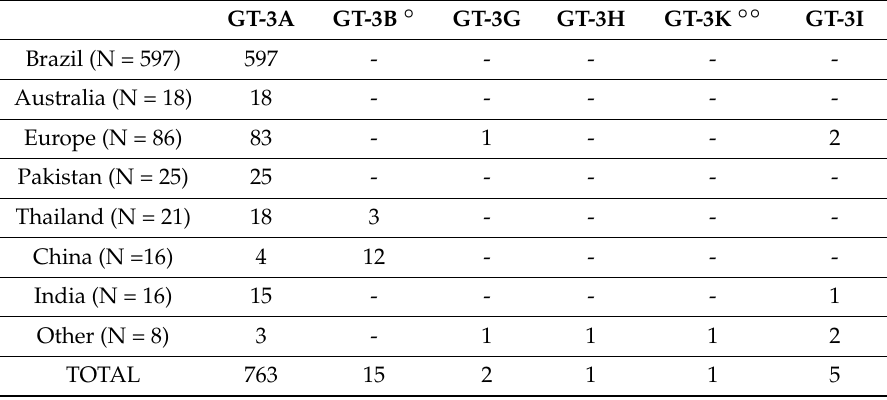
Table 1. Geographic distribution of GT-3 subtypes in Los Alamos HCV